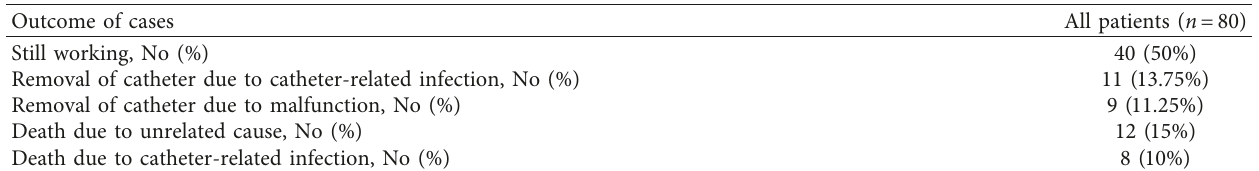
Table 4: Outcome of cases and endpoint of